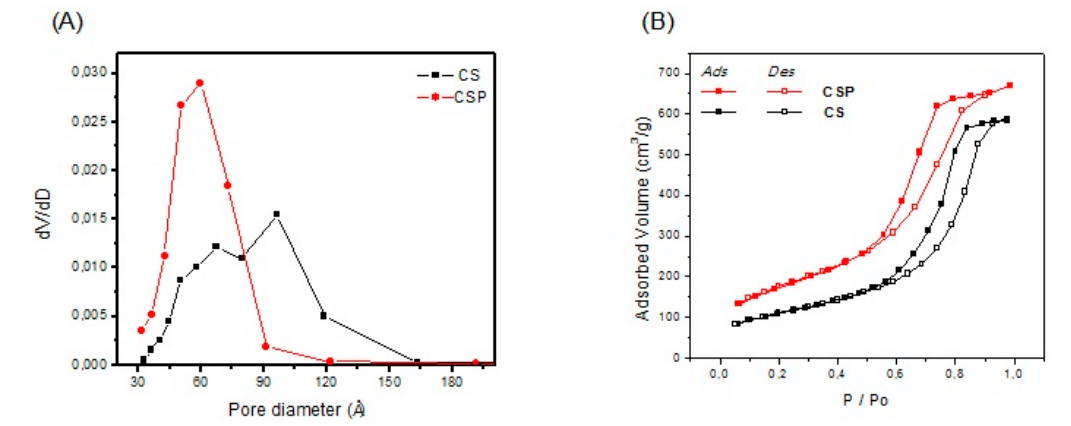
Figure 3. BET ( A ) and Nitrogen adsorption and desorption isotherm ( B ) for CS and CSP.